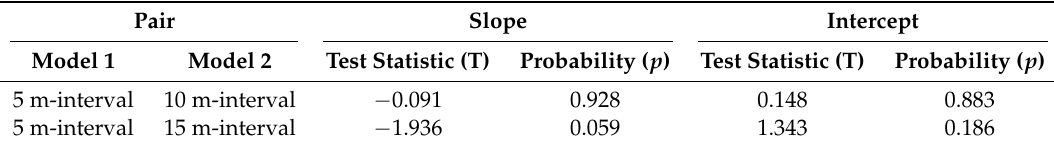
Table 5. The t -test results of comparing linear